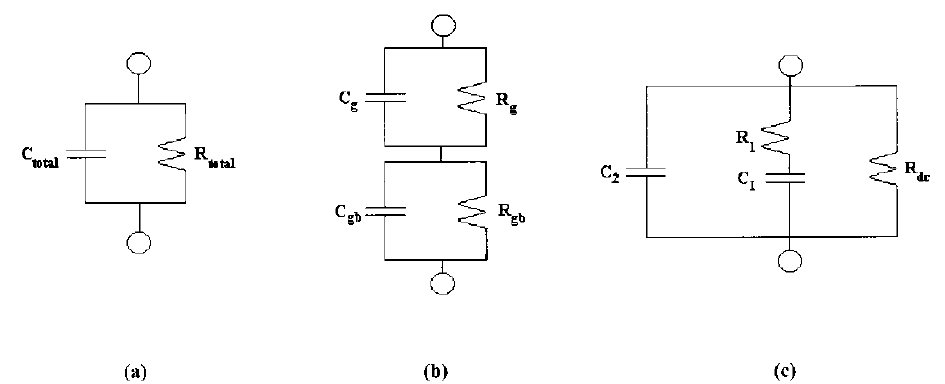
FIGURE 10 Equivalent circuit model: (a) elements extracted as absolute lumped elements obtained in the Z *-plane, (b) elements extracted as a voltage dividing configuration obtained in the M *-plane, (c) trapping response within the grain-boundary depletion regions obtained in the